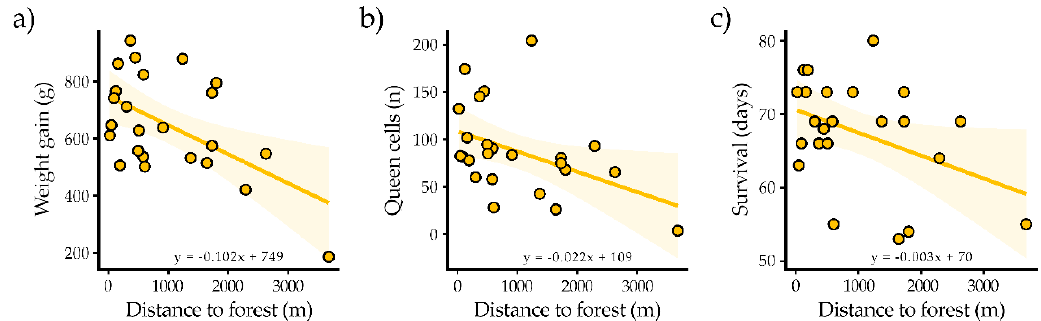
Figure 2. Relations of ( a ) weight gain (t 1,22 = − 2.28, R 2 mult = 0.191, and p = 0.033), ( b ) number of queen cells (t 1,22 = − 3.09, R 2 mult = 0.302, and p < 0.01), and ( c ) survival and distance to forests (t 2,21 = − 2.67, R 2 adj = 0.286, and p = 0.015). Predicted linear relations (regression lines) and 95% confidence intervals (shaded area) are drawn for significant relations.